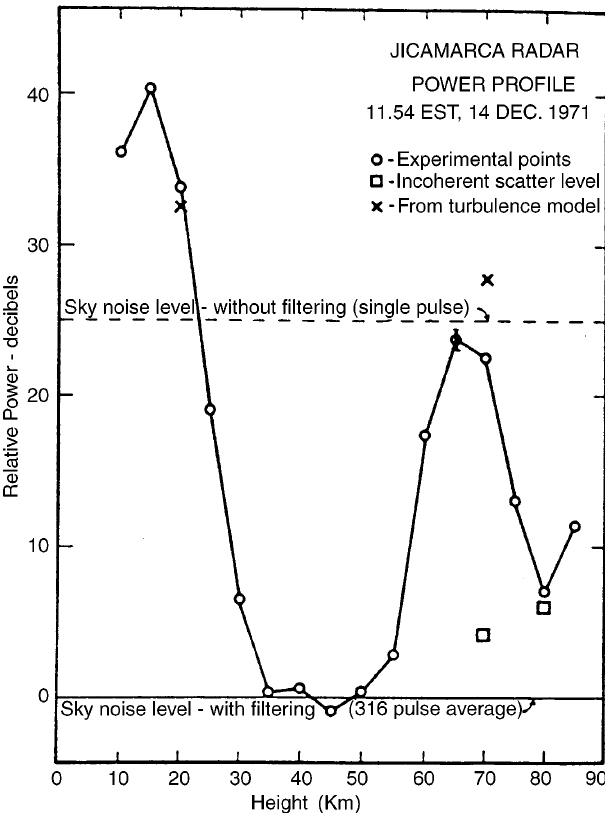
Fig. 5. Backscattered power profile observed by the 50 MHz Jicamarca radar (from Woodman and Guille´